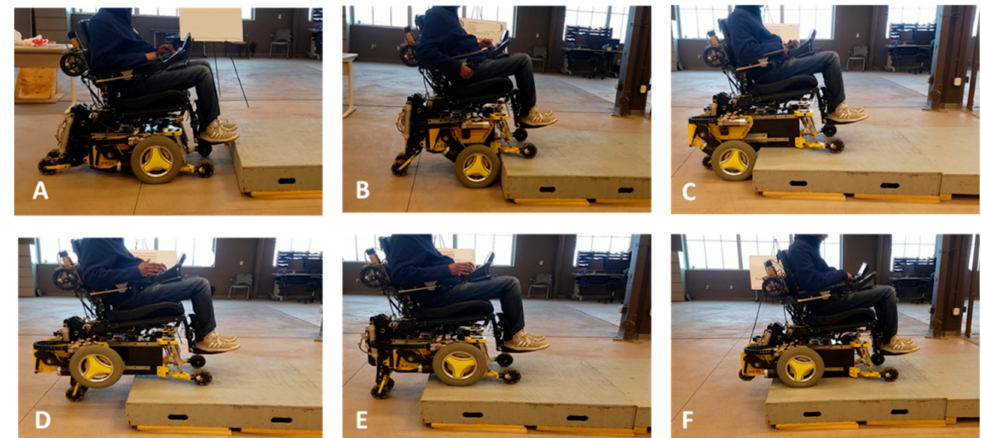
Figure 1. MEBot curb ascending process: ( A ) starting position; ( B ) the MEBot elevates and drives until front driving wheels touch the curb; ( C ) driving wheels move back, allowing the center of mass to shift onto the curb; ( D ) driving wheels are raised; ( E ) driving wheels move forward and onto the curb; and ( F ) driving carriage moves back whilst driving forwards and rear castors are raised until the MEBot is completely on the